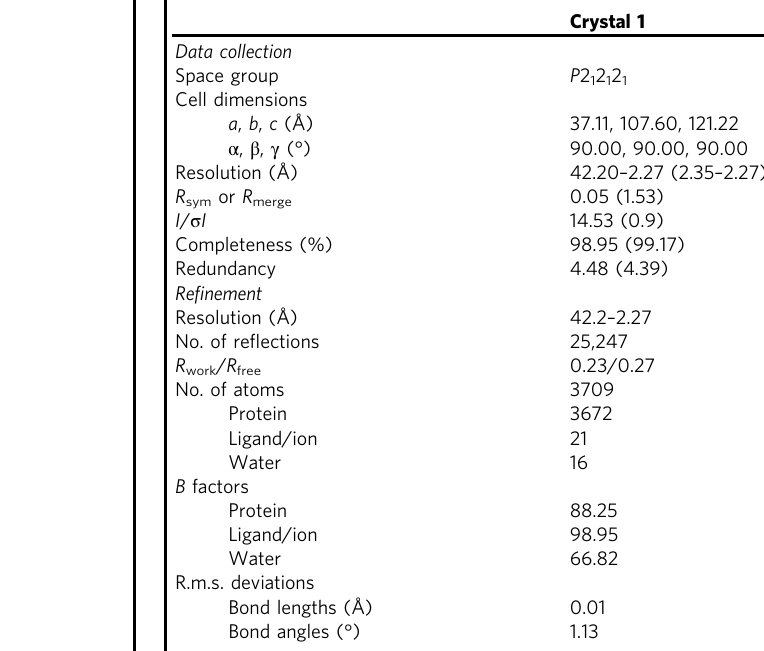
Table 2 Data collection and re fi nement statistics (molecular